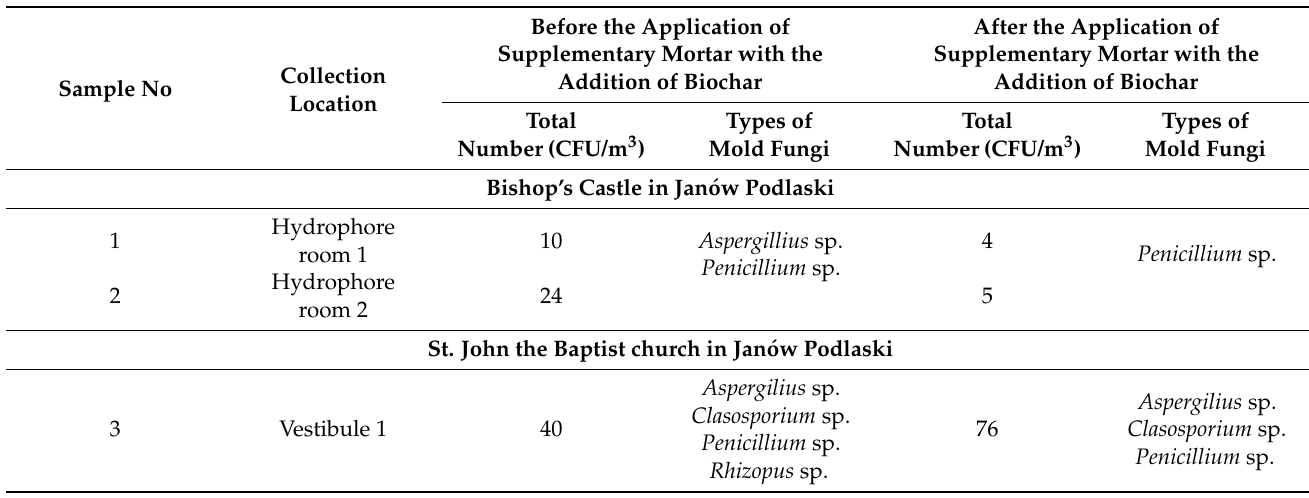
Table 3. Mold fungi isolated from the air in the rooms of the examined historical buildings before and after the application of supplementary mortar with the addition of